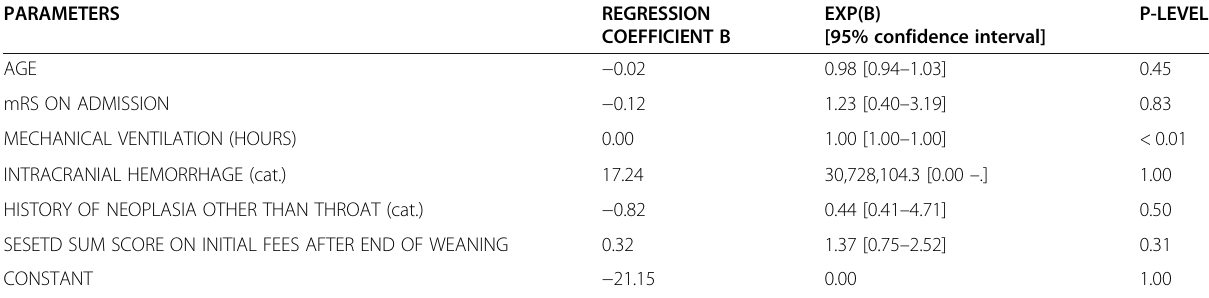
Table 2 Logistic regression analysis for decannulation failure mRS = modified Rankin Scale; cat = categorical; Nagelkerke R 2 : 0.175 PARAMETERS